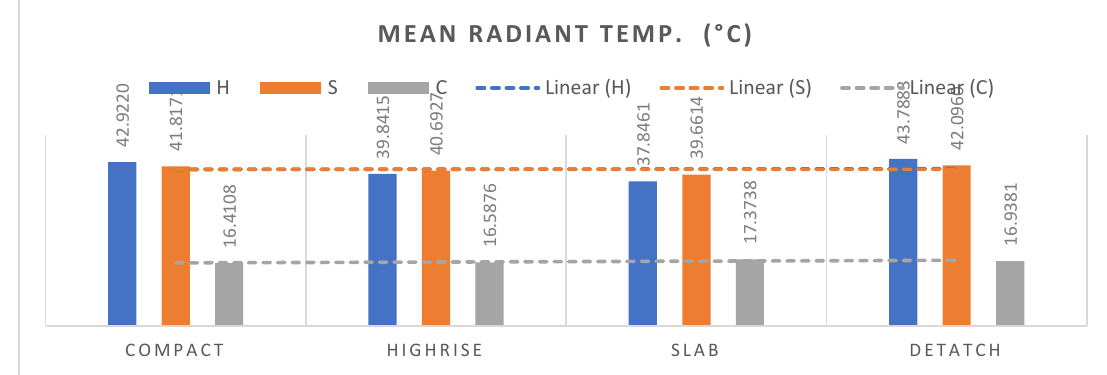
Fig. 18: Comparison of average mean radiation temp from simulation performed on the hottest, coldest and sultriest days of the year be - tween four selected morphotypes Table 6: Mean results of microclimate parameters in four morphotypes and ranking and weighting of evaluation results